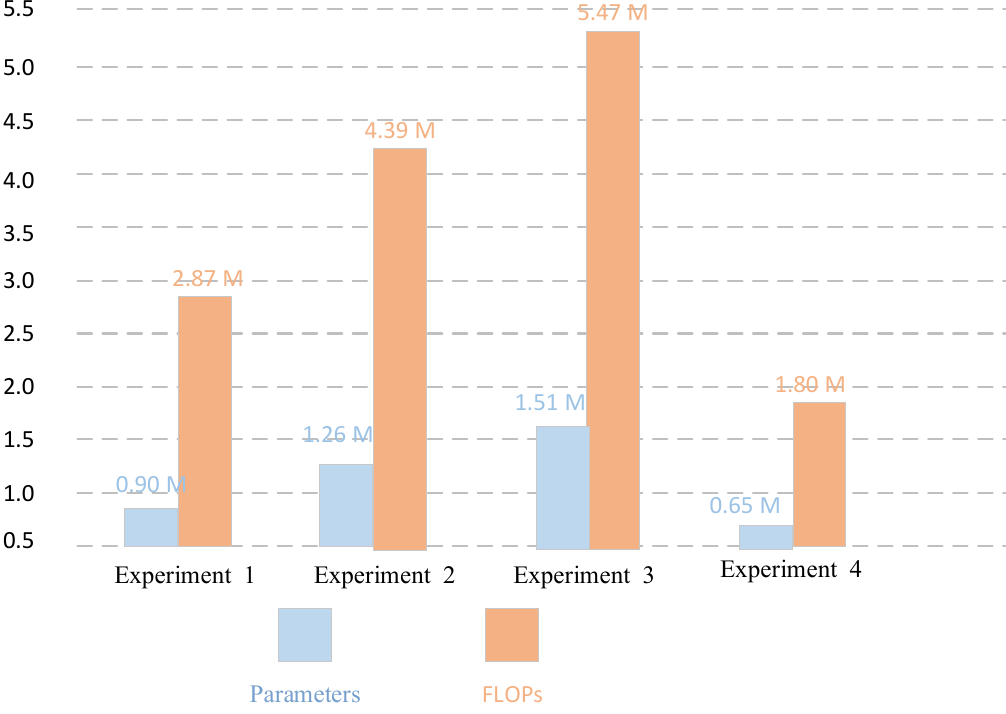
Figure 18. Comparison of parameters and FLOPs values between dimension-wise convolution and traditional convolution on UC dataset with training ratio of 80%.